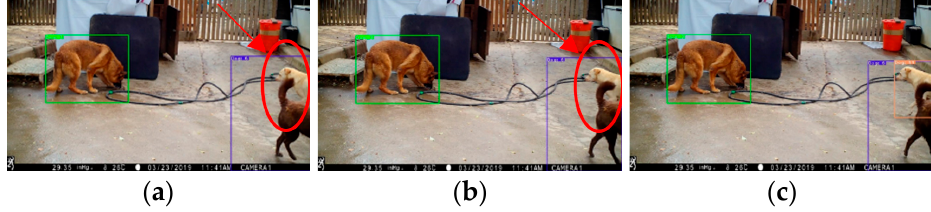
Figure 20. Dog with ID 4 not tracked in images 302 and 303. (a) Image 302; (b) Image 303; (c) Image 304.